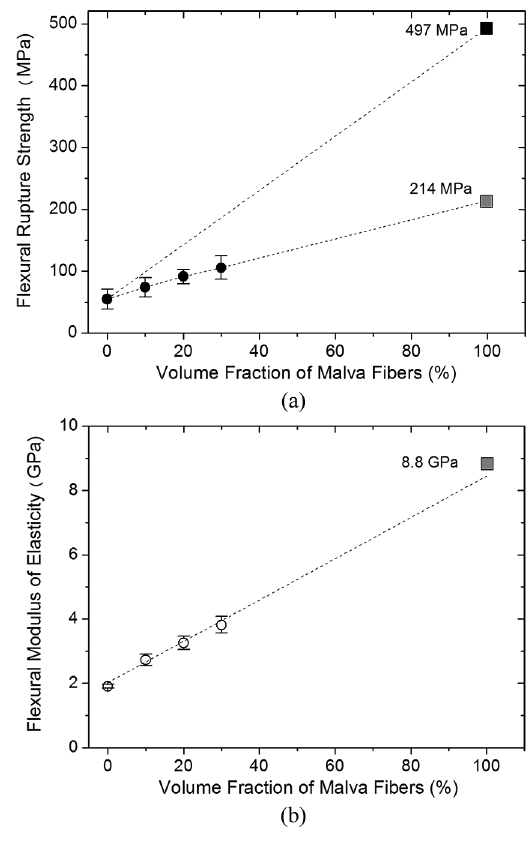
Figure 7. Experimental data and corresponding Rule of Mixtures: (a) flexural strength and (b) flexural